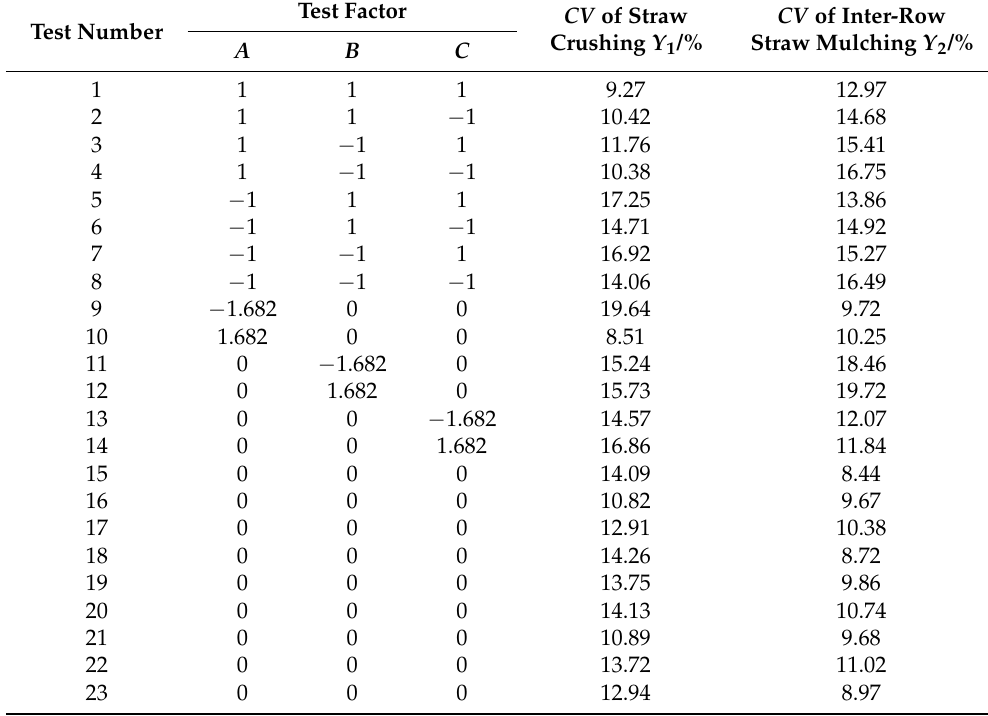
Table 3. Test schemes and